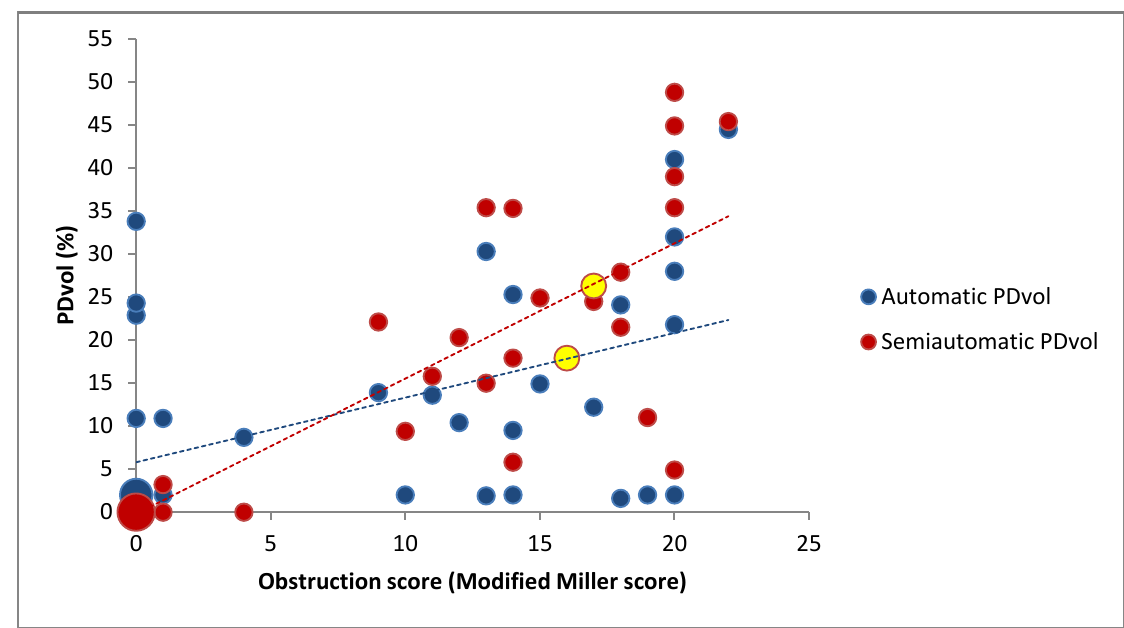
Figure 5. Scatterplot of obstruction score and perfusion defect volume (PDvol) ( n = 43). Line of best fit is shown with a dotted line. The large red dot in the left corner of the scatterplot represents 18 patients, while the large blue dot in the left corner represents 14 patients. The yellow dots represent patients with identical automatic and semiautomatic PDvol.